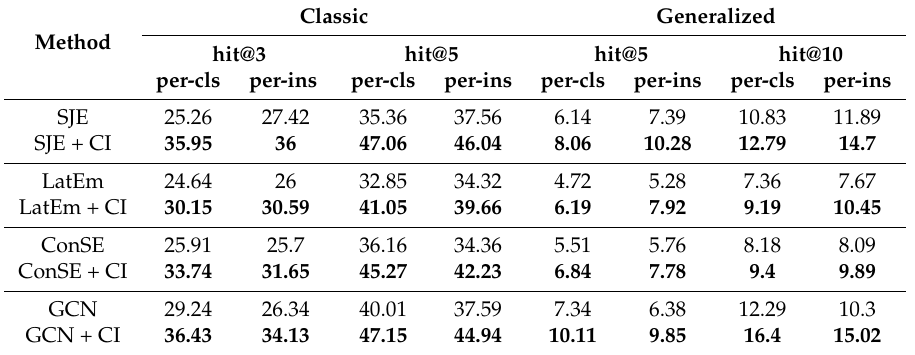
Table 3. Top-n prediction results of HM path by applying contextual inference (CI) to the